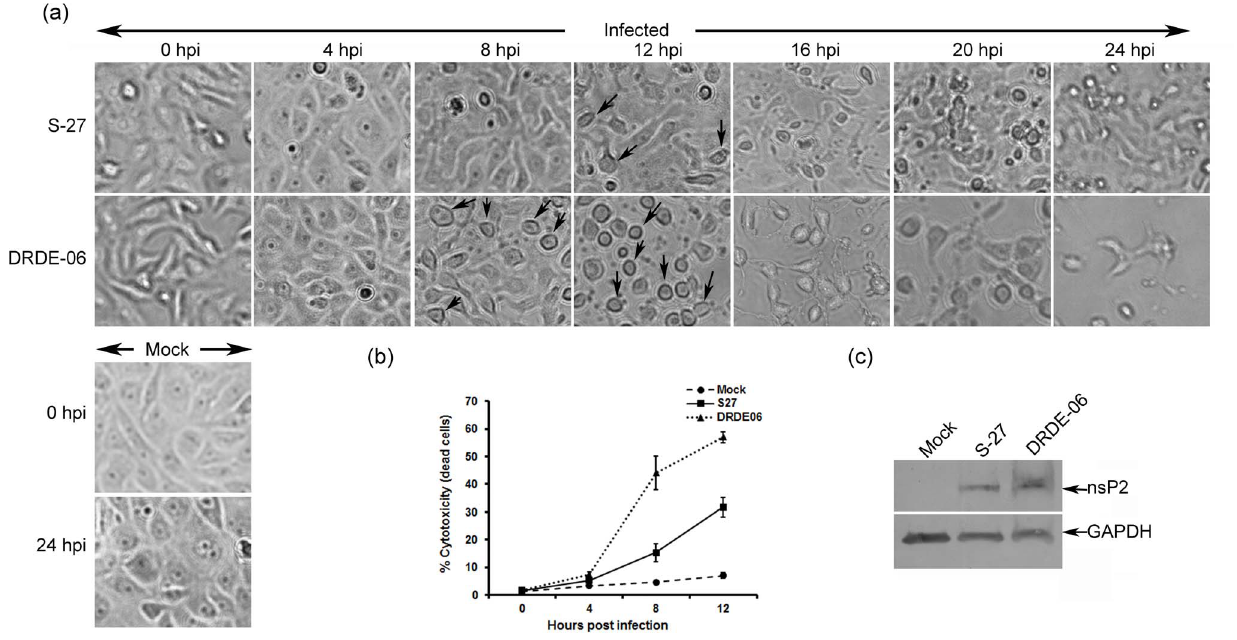
Figure 1. Comparison of Biological phenotypic characteristics of S-27 and DRDE-06 Chikungunya virus strains. Vero cells were infected with the viral strains with MOI 1. (a) Cytopathic effects (CPE) were observed under microscope (Magnification 2 20 6 ) at different time points and arrows are indicating the cell showing CPE (at early time points only). (b) The cytotoxicity was calculated by counting the live and dead cells by trypan blue stains from three independent experiments. (c) Infected cells were harvested at 16 hours post infection (hpi) for S-27 and at 8 hpi for DRDE-06 based on the observation of highest CPE. Viral protein expression was checked in Western Blot using nsP2 antibody. GAPDH was used as a loading control.